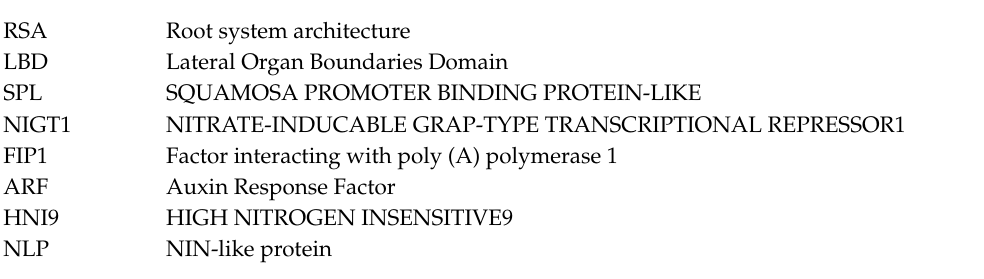
Table S1. A ff ymetrix Arabidopsis ATH1 Genome Microarray of Anatomical Part: